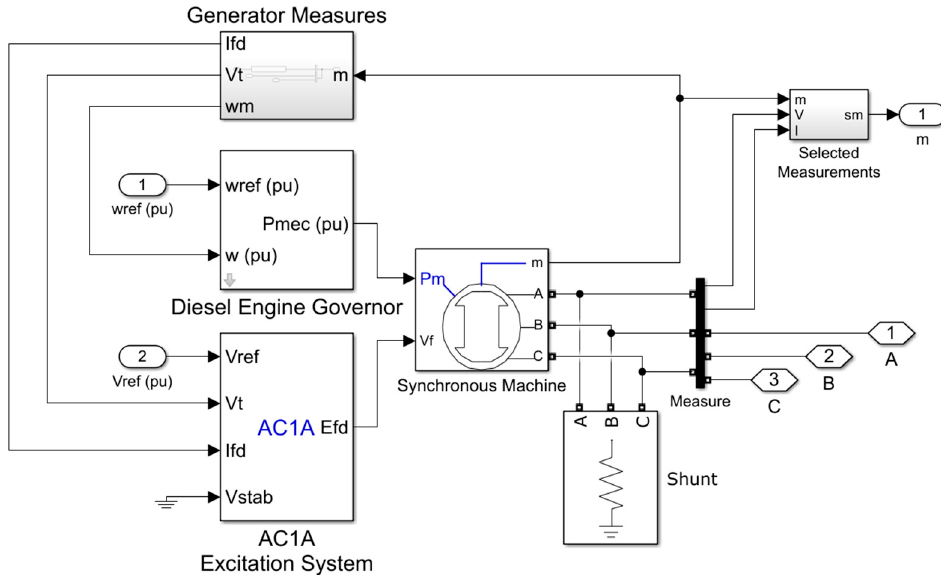
Figure 9. Schematic model of diesel generator.